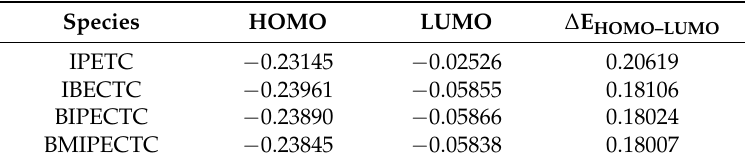
Table 4. Calculated energies of HOMO and LUMO